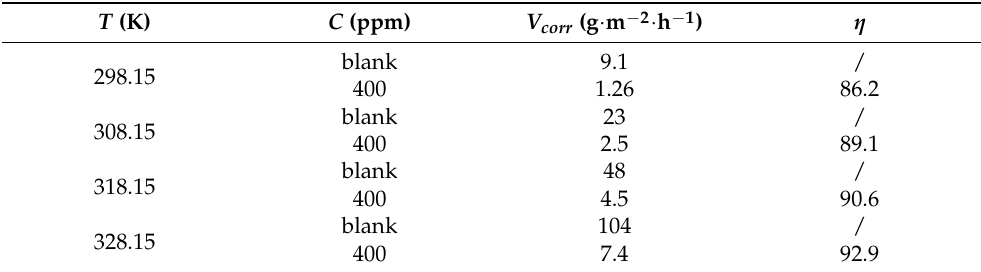
Table 3. The weight loss results for steel after 12 h of exposure to 1 M HCl solution in the absence and presence of 400 ppm NCDs at various